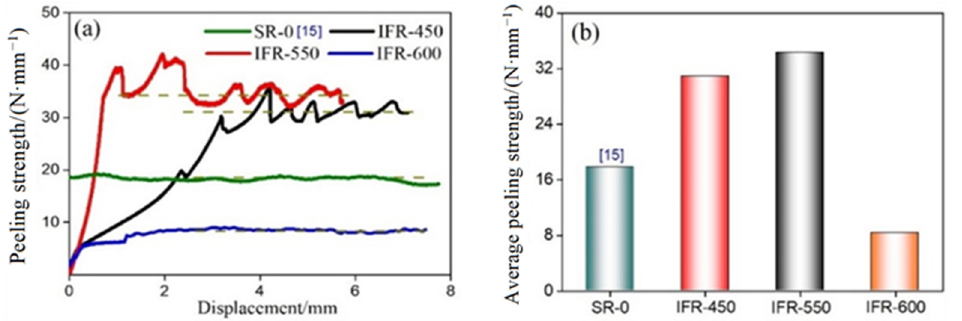
Figure 11. Peeling strength curves ( a ) and average peeling strength ( b ) of Cu/Al clad sheets with SUS304 interlayer annealed at different temperatures.